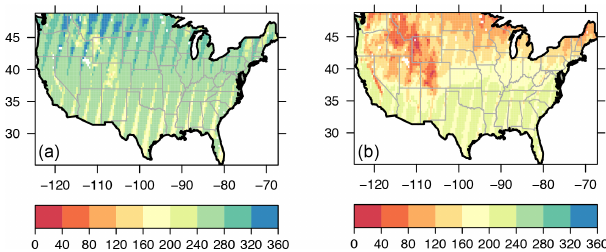
Figure 1. Number of retrievals for each season. (a) Warm season (1 April–30 September); (b) cold season (1 October–31